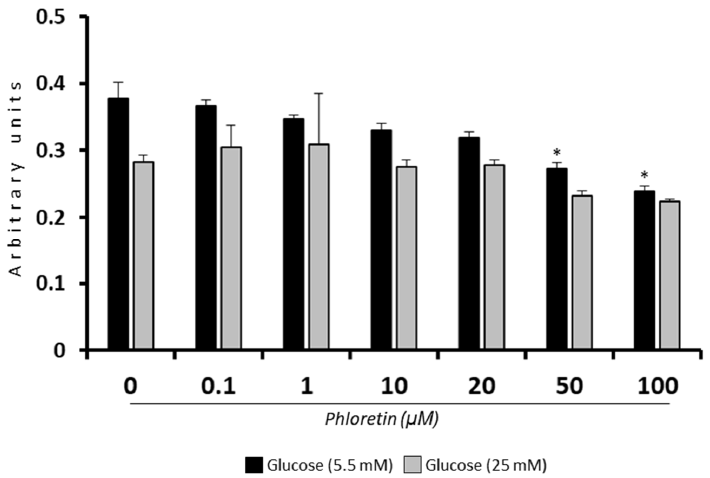
Figure 1. Effect of phloretin concentration on MSC viability in presence of 5.5 or 25 mM of glucose. * p < 0.05 vs. untreated cultures (0 µM of phloretin).